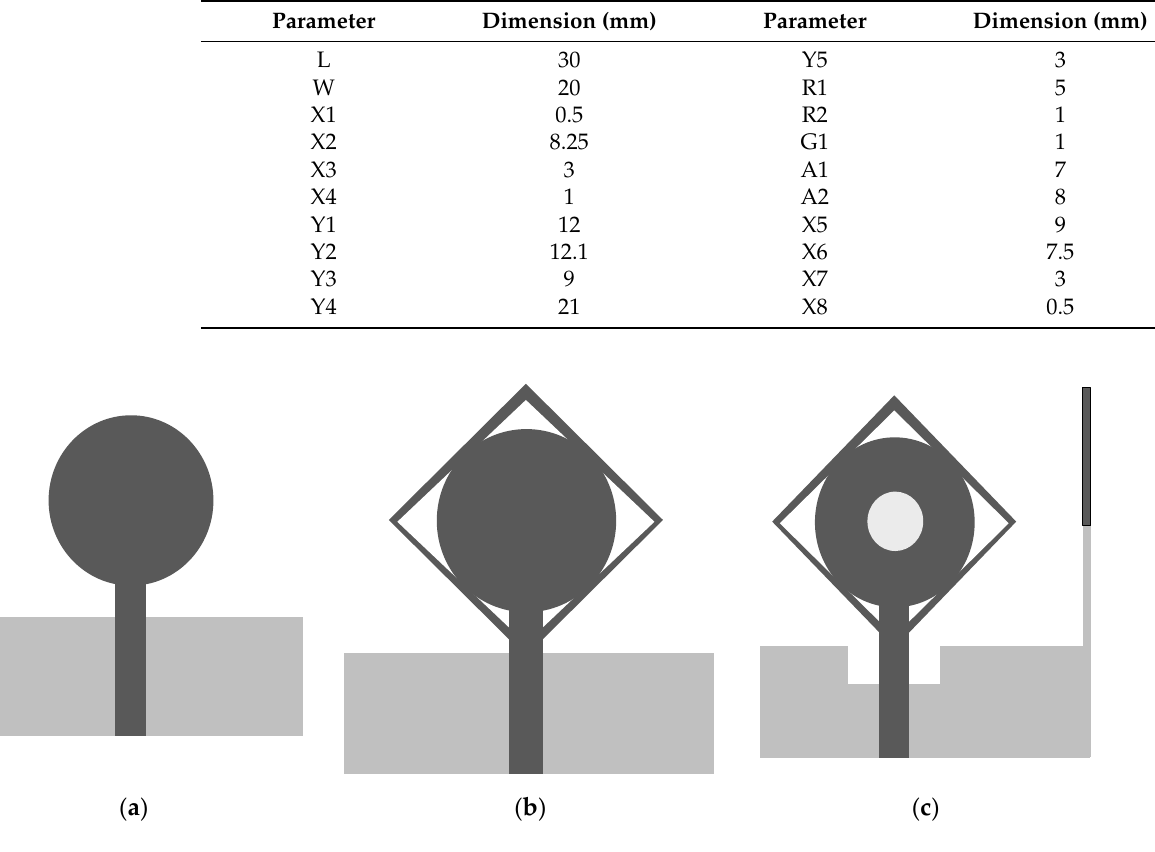
Figure 2. Antenna investigation analysis ( a ) Type I, ( b ) Type II, and ( c ) Type III.